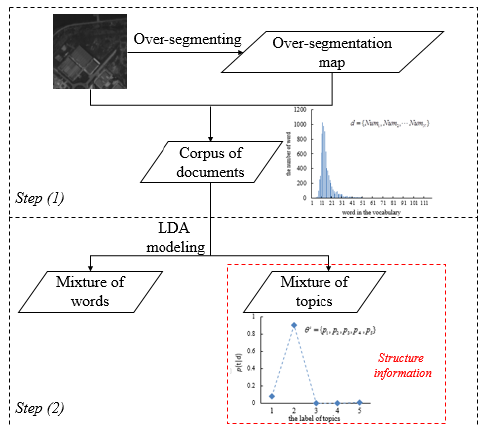
Figure 2. The process of modeling the structure information of the remote sensing image. Figure 3. The process of the proposed method.